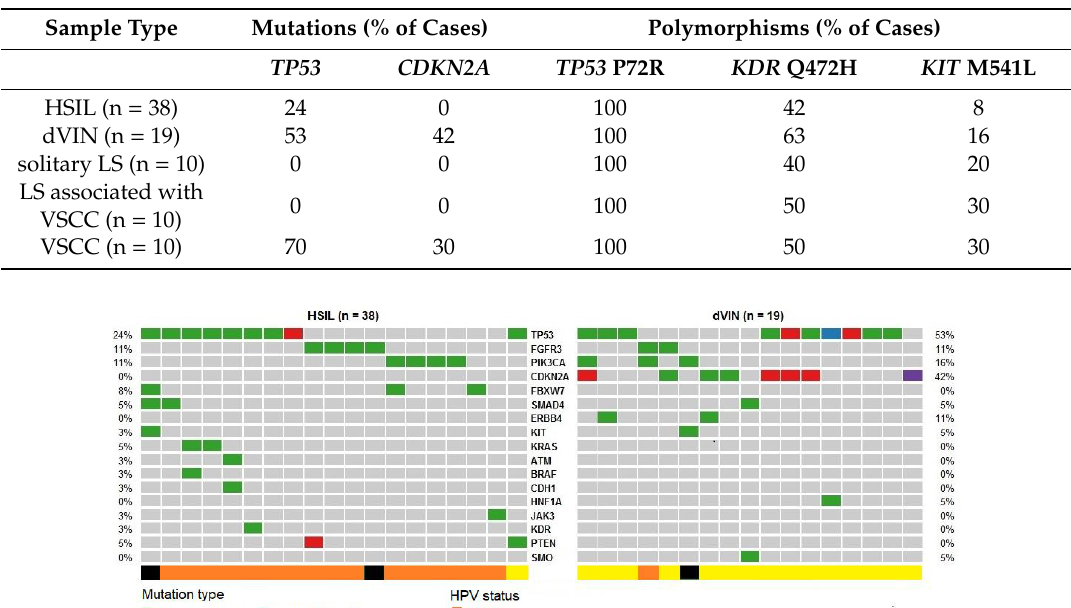
Table 1. Most frequent mutation and polymorphism rates in HSIL, dVIN, lichen sclerosus (LS) and vulvar squamous cell carcinoma (VSCC) samples.